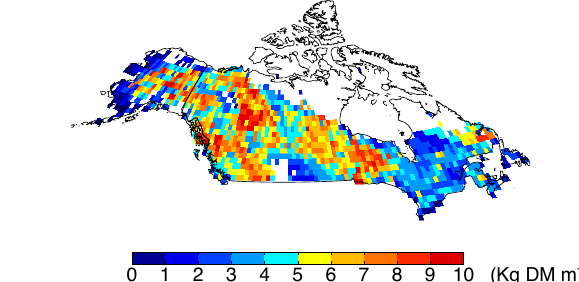
Figure 2. Fuel consumption over Alaska and Canada (a) for mod- erately dry conditions and (b) weighted by the Drought Code (DC) and area burned for 1980–2009. The average values are shown in